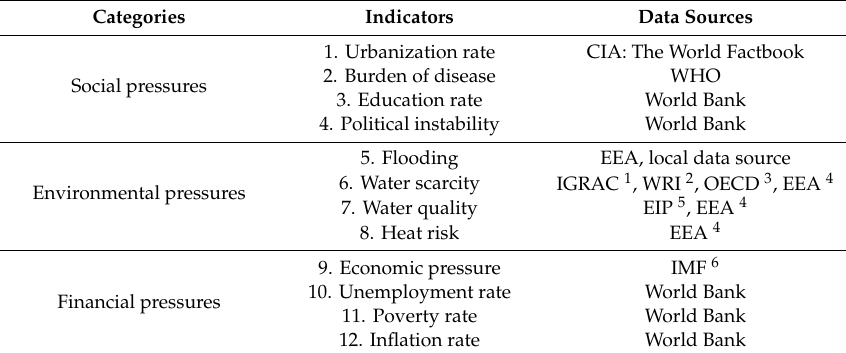
Table 1. Indicators of the Trends and Pressures Framework and data sources [17].